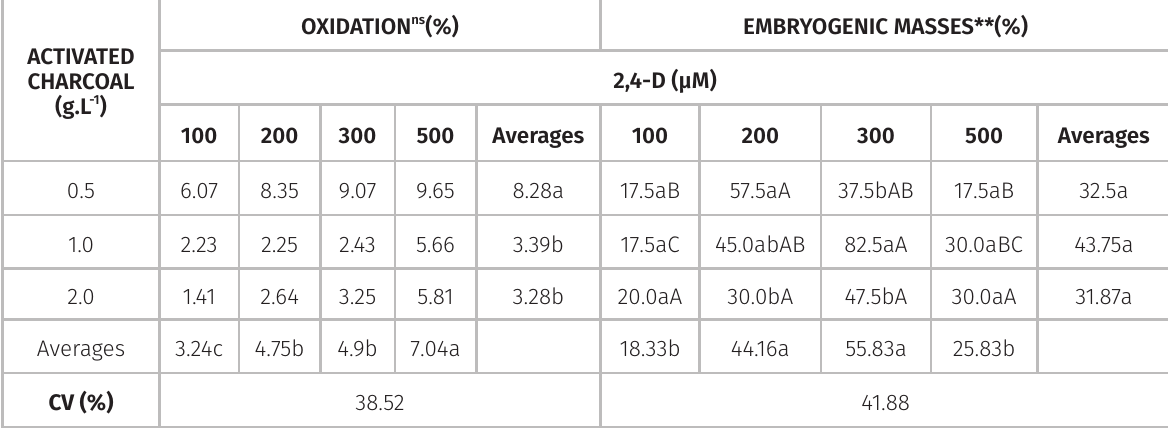
Table I. Oxidation and embryogenic mass formation in Plinia cauliflora seeds cultured in MS culture medium, according to 2,4-D and activated charcoal concentration, 60 days after in vitro